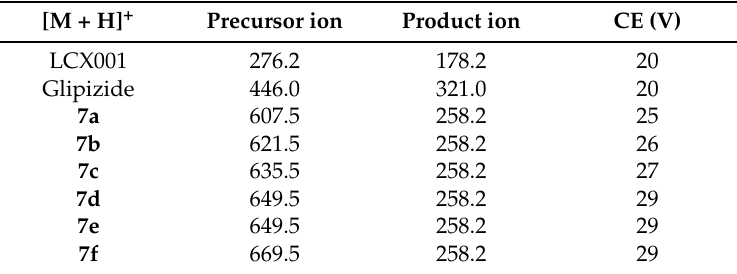
Table 5. Mass spectrometric conditions for the